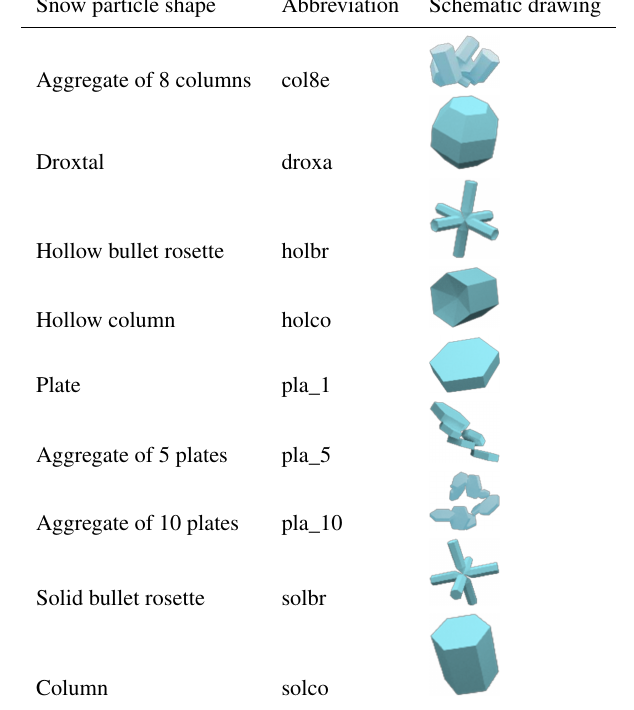
Table 1. Snow particle shape provided in Yang et al. (2013) database. The abbreviations introduced here will be used